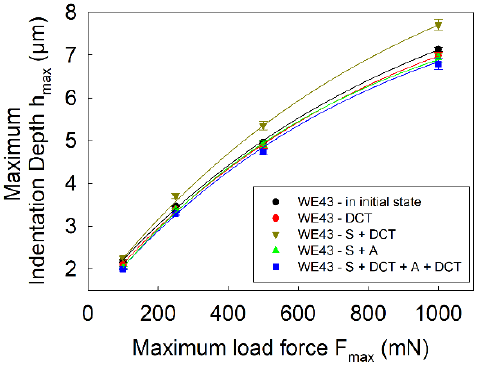
Figure 6. Maximum depth of indenter penetration h max during microindentation tests of WE43 mag- nesium alloy. The error bars represent a standard deviation ( σ hmax = 0.02–0.13 µm) .